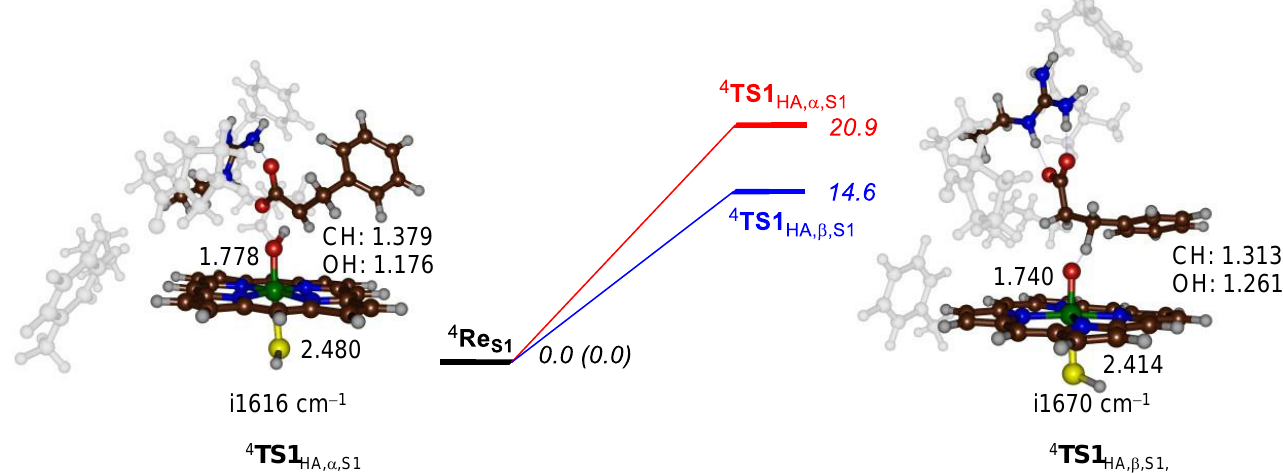
Figure 3. Hydrogen atom abstraction steps from substrate S1 by CpdI of P450 OleT JE . The middle panel shows relative energies in kcal mol − 1 as obtained at the ∆ E BS2 +ZPE BS1 level of theory. Hydrogen atom abstraction transition state structures are shown on the side with bond lengths in angstroms and the imaginary frequency in the transition state in cm − 1 .